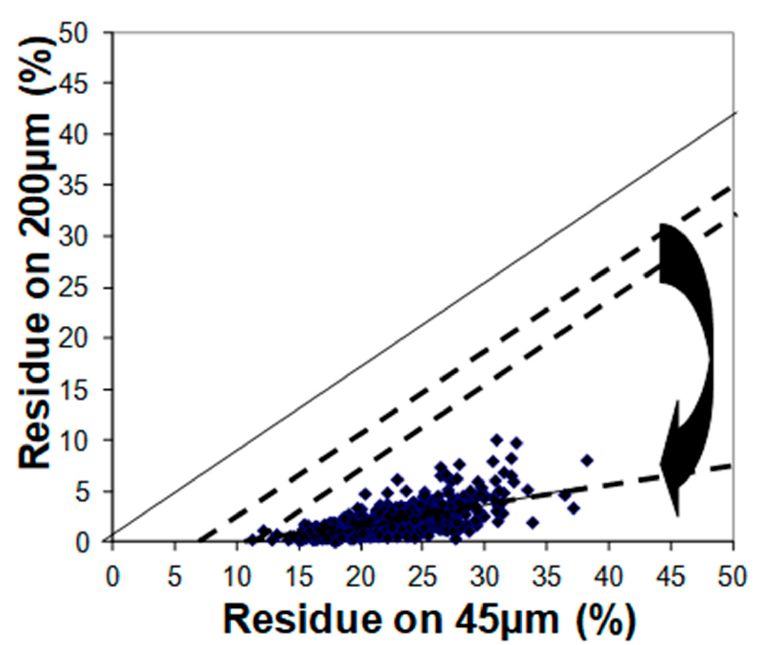
Figure 8. Relationship between the coal fly ash retained on the 45 µ m and 200 µ m mesh sieves, calculated from 765 spot samples picked in a period of ten